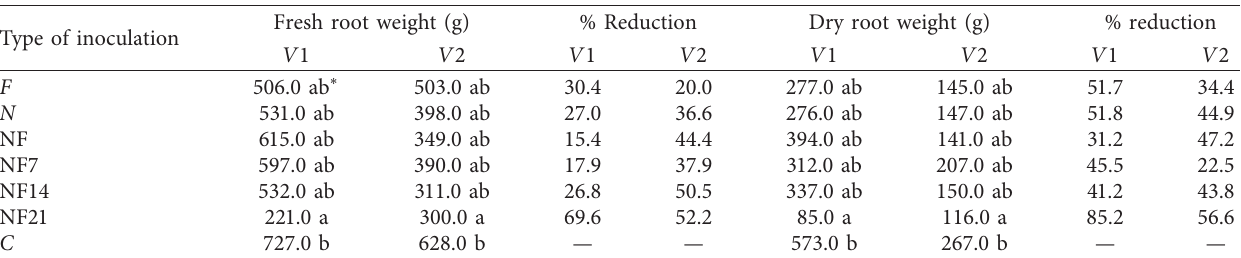
Table 2: Fresh root weight and dry root weight for “Essoumtem” and “Clemson spineless” under various inoculations in pot experiment. Type of